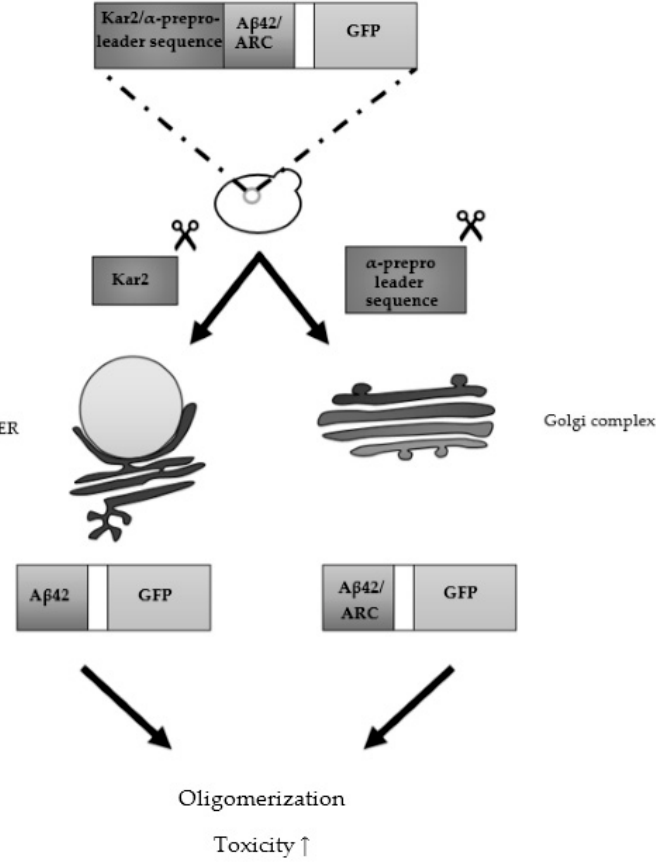
Figure 3. Humanized yeast model expressing GFP-fused A β peptides tagged with an endoplasmatic reticulum (ER) or Golgi complex targeting sequence. Treusch and colleagues expressed A β 42 N-terminally tagged with the Kar2 sequence, while D’Angelo and colleagues expressed A β 42/ARC N-terminally tagged with the α prepro-leader sequence (with and without a C-terminal GFP tag). The scissors icon indicates cleavage of the respective proteins.